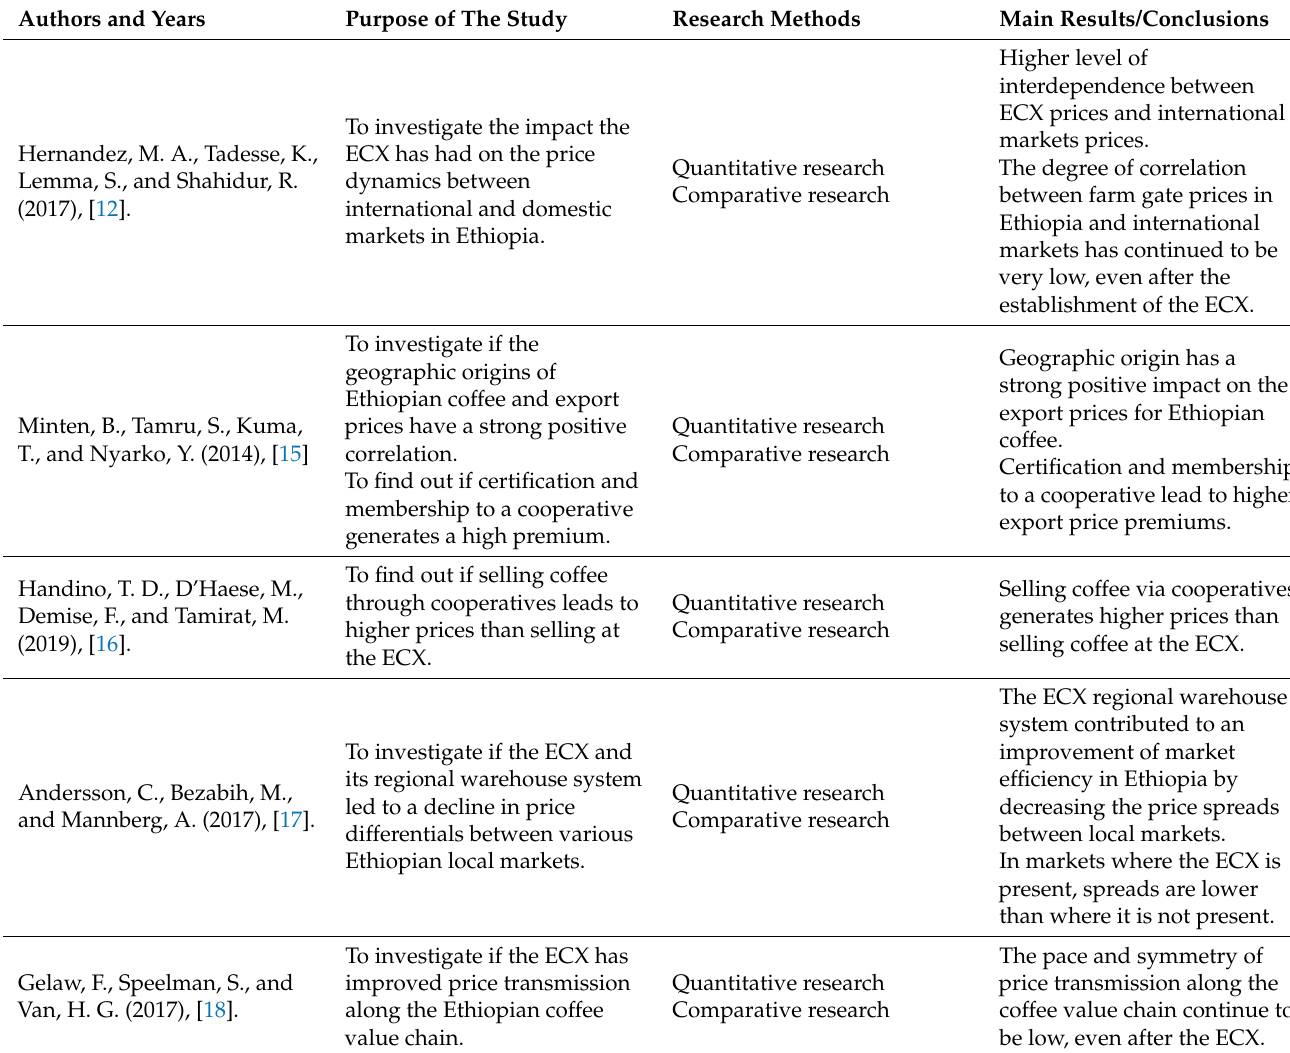
Table 1. Literature review